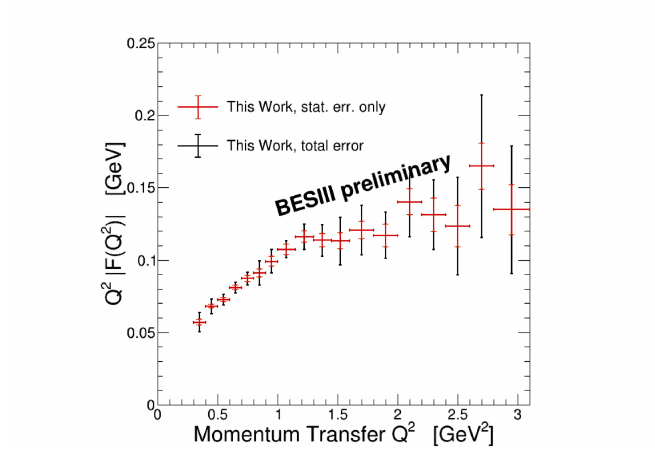
Figure 4: The preliminary result of the π 0 TFF from the BESIII